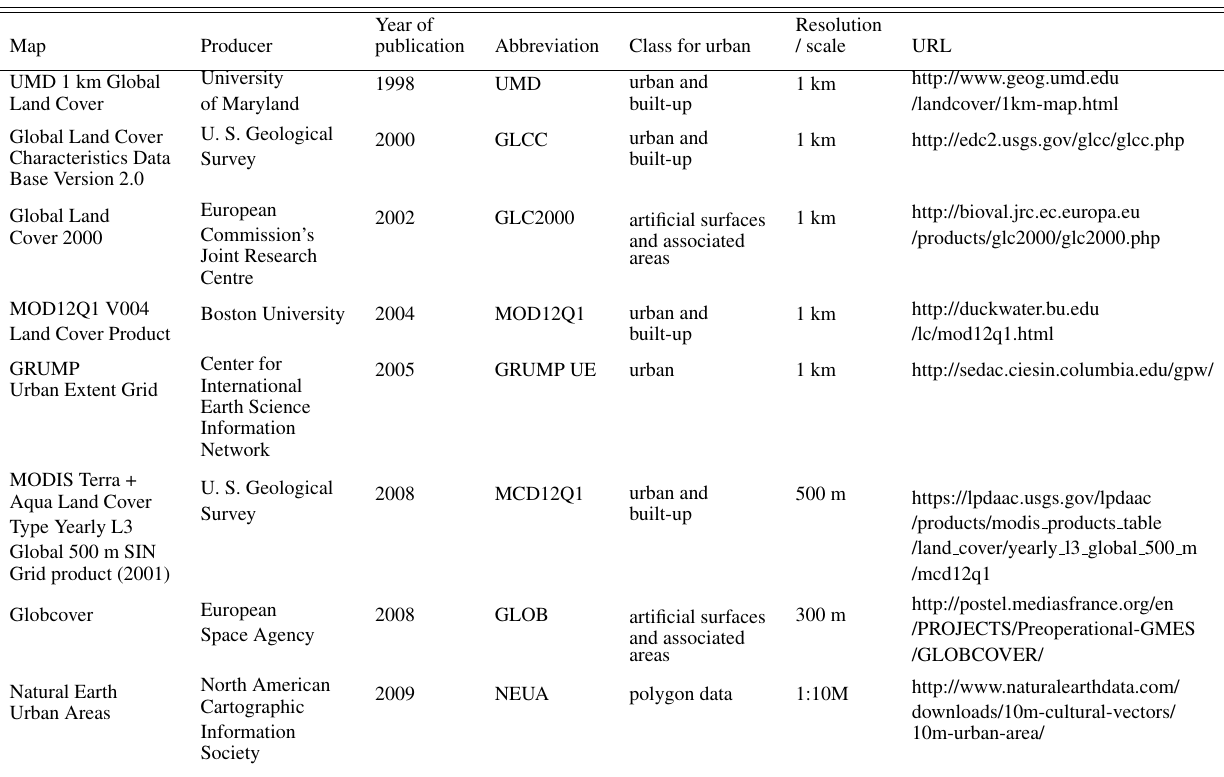
Table 1. The urban area maps validated in this study. Except for the MCD12Q1 and the NEUA, the maps were validated without correction for the different map projections. In the case of the MCD12Q1, which was published in sinusoidal projection by tiles, the image tiles were merged and resampled onto a grid of 0.004 degrees of latitude and